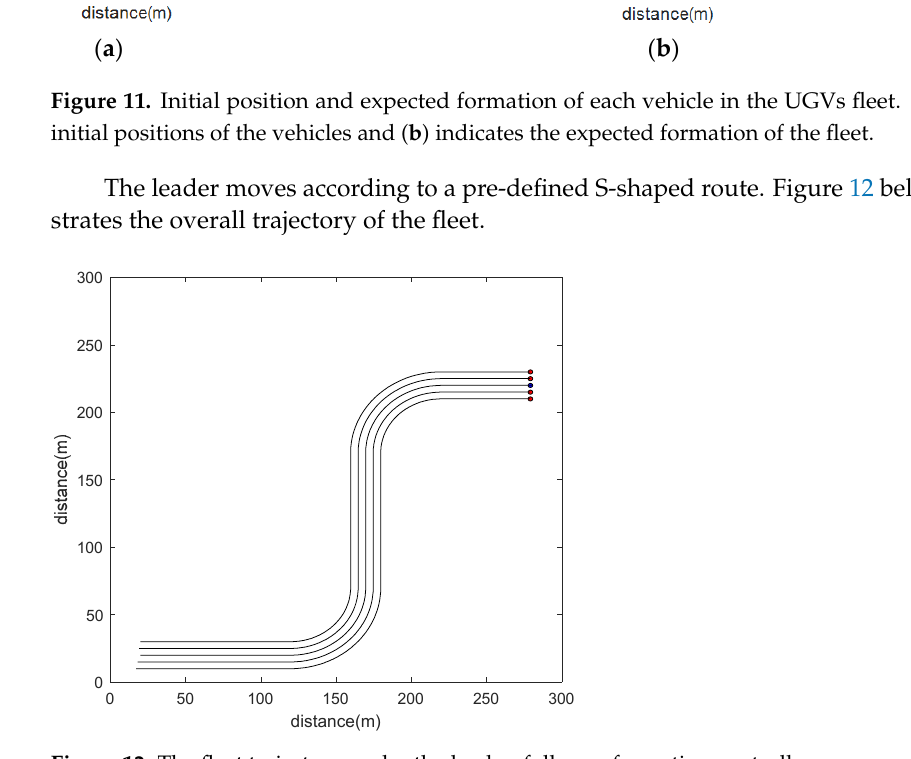
Figure 12. The fleet trajectory under the leader–follower formation controller.